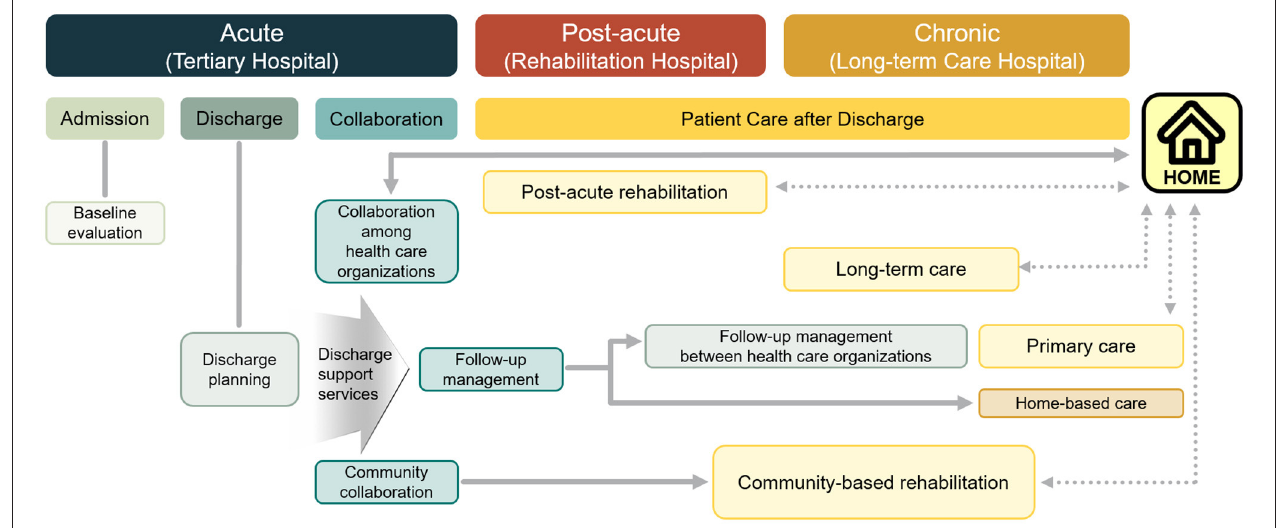
FIGURE 1 | Medical rehabilitation delivery system for patients with